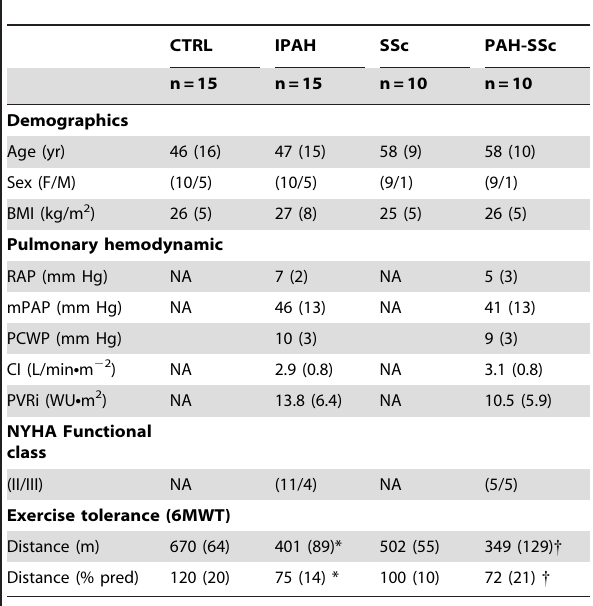
Table 1. Characteristics of the study